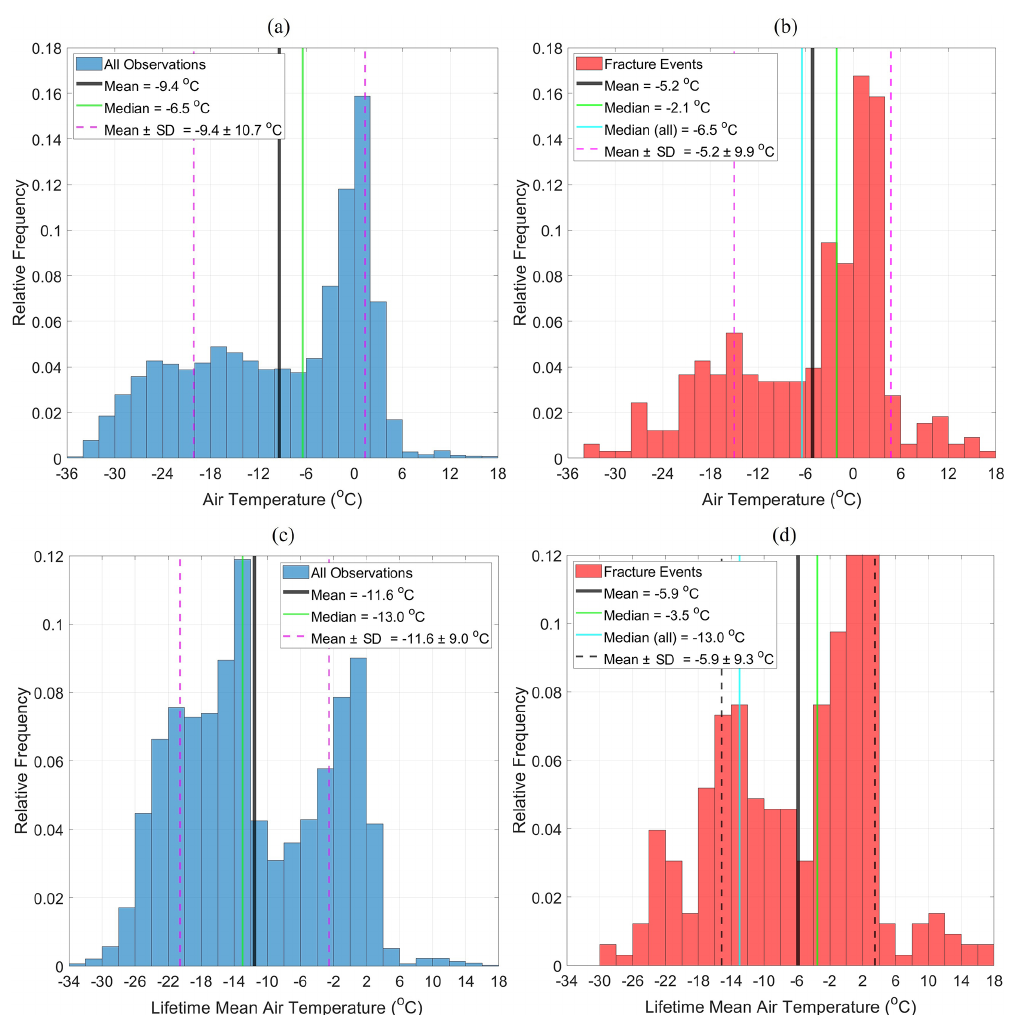
Figure 4. Relative frequency histogram plots of air temperature ( a ; n = 17735, b ; n = 328) and lifetime mean air temperature ( c ; n = 17755, d ; n = 328) surrounding the Petermann ice islands for all observations (a, c) and for the fracture events (b, d)